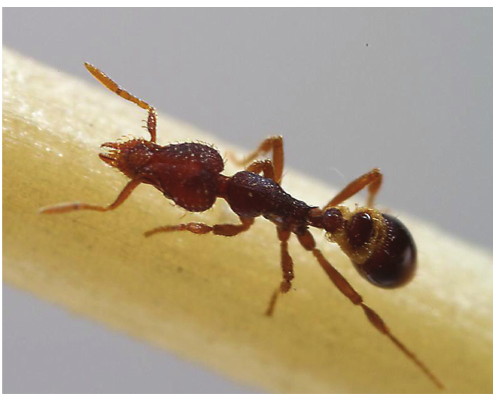
Figure 6: Pyramica rostrata worker foraging in artificial